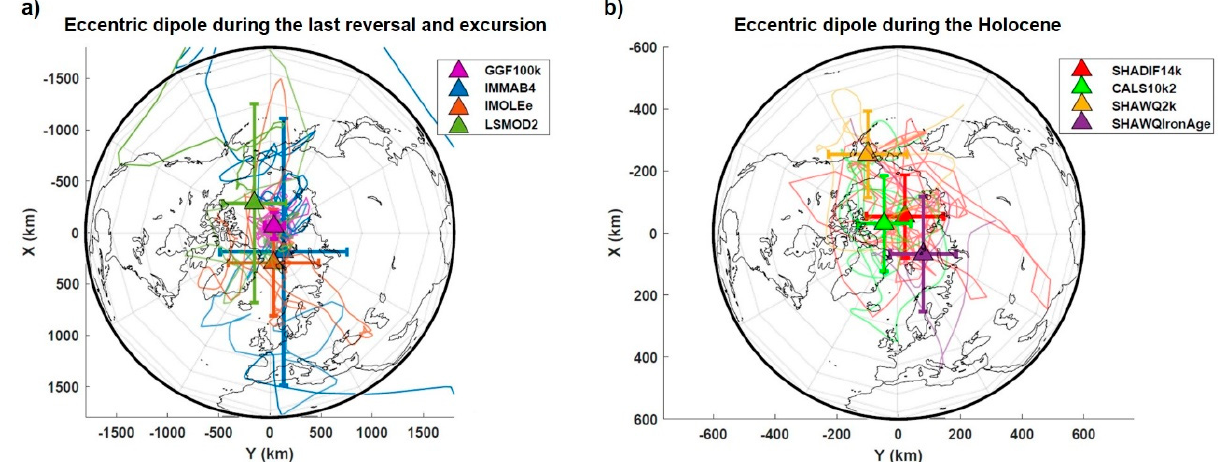
Figure 6. Thin lines represent the geomagnetic eccentric dipole (ED) locations in the equatorial plane relative to Earth’s center ( a ) during the last reversal and excursions and for the last 100 kyr according to the IMMAB4 (blue), IMOLEe (orange), and LSMOD.2 (green), and GGF100k (purple) paleoreconstructions, respectively, and ( b ) during the Holocene according to SHADIF14k (red), CALS10k2 (green), SHAWQ2k (yellow), and SHAWQ-Iron Age (purple) paleoreconstructions. Triangles are the time-average location of the ED for each paleoreconstruction calculated as the mean position in each axis. X and Y correspond to the geocentric cartesian axes contained in the equatorial plane and pointing to 0° and 90° E longitude, respectively. Note the different scales between both figures. Coastlines are plotted only for longitude reference (note they are projected on a sphere of arbitrary radius).